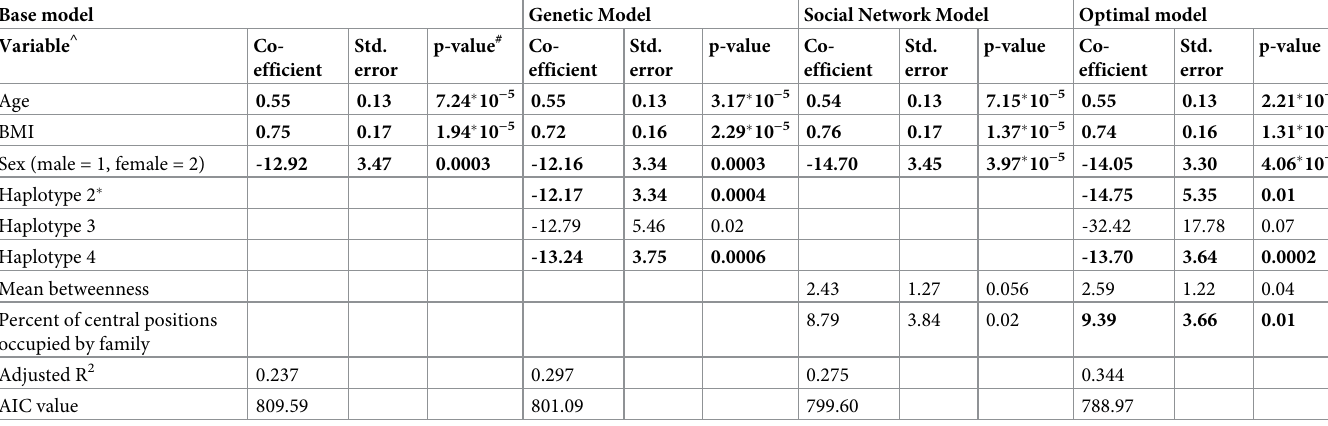
Table 4. SBP model selection using multilinear